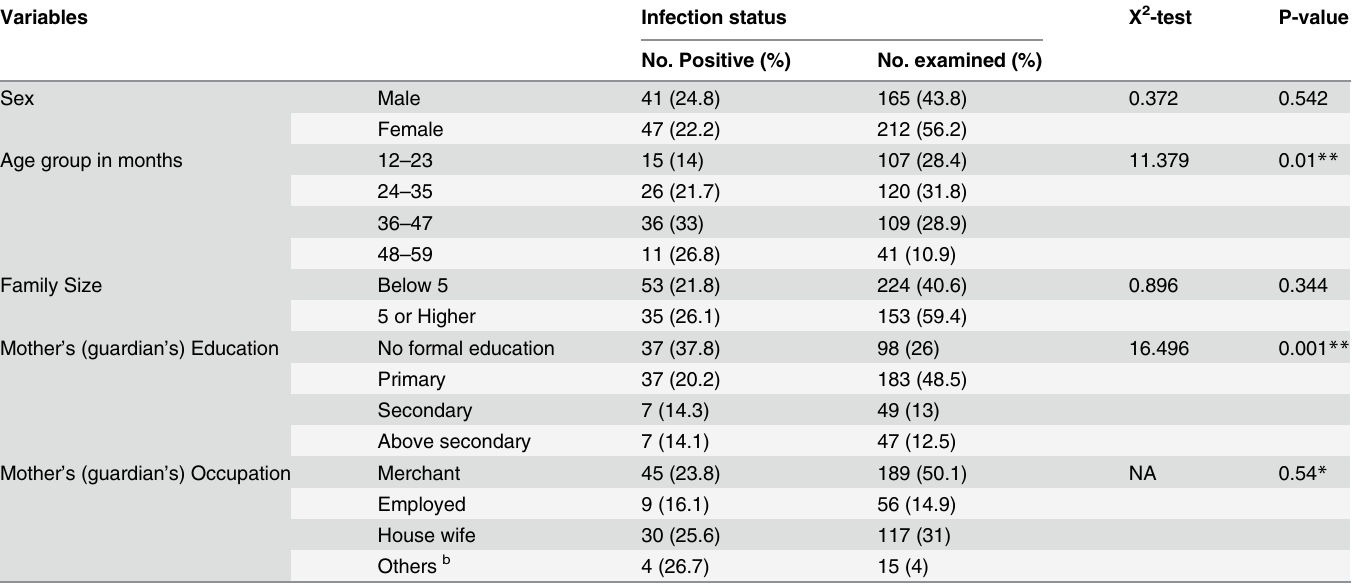
Table 1. Soil-transmitted helminth infections in relation to socio-demographic characteristics of the pre-school aged children, Butajira, Southern Ethiopia, 2014. Variables